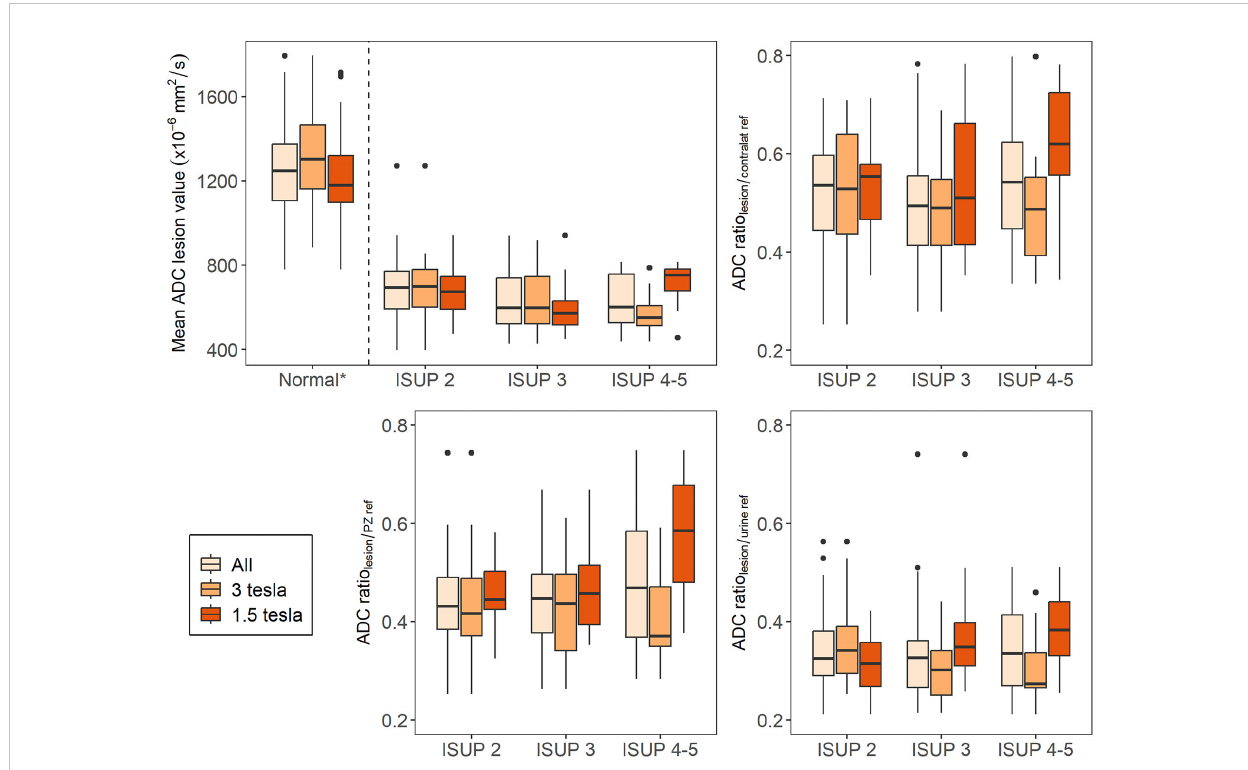
FIGURE 3 Box-and-whisker plots of apparent diffusion coef fi cient (ADC) metrics for tumors strati fi ed by ISUP grade. (*) Normal represents the absolute ADC value of the normal appearing tissue in the contralateral position of the index lesion.